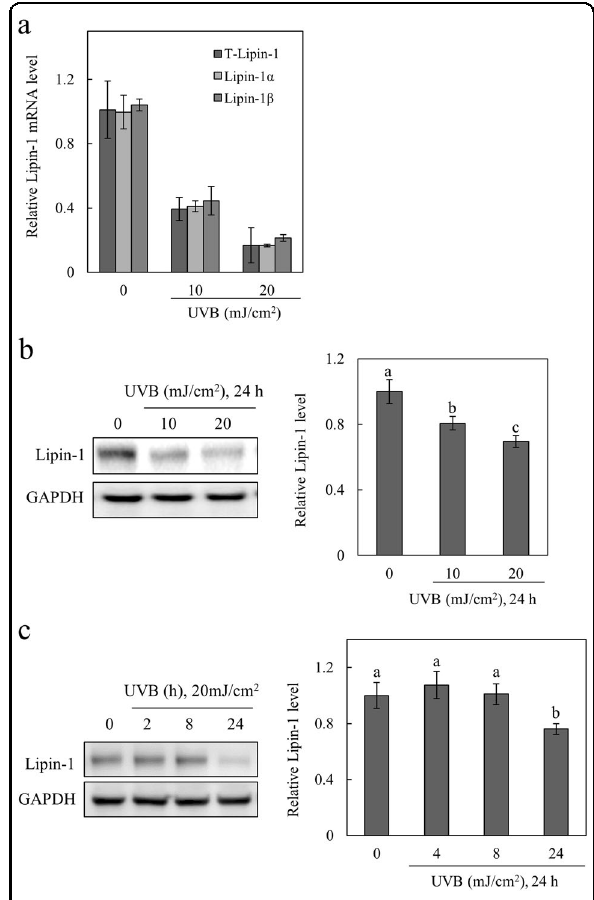
Fig. 1 UVB downregulates lipin-1 expression in NHEKs. NHEKs were treated with different doses of UVB (0, 10, and 20 mJ/cm 2 ) radiation and cultured for 24 h. a Total RNA was extracted from the cells, and relative mRNA levels of total (T) lipin-1, lipin-1 α , and lipin-1 β were measured via SYBR GREEN RT-PCR analysis. b Cell lysates were subjected to immunoblot analysis to assess lipin-1 expression levels. Protein levels of lipin-1 were normalized to GAPDH. c NHEKs were treated with 20 mJ/cm 2 UVB radiation and harvested at the indicated time points (0, 4, 8, and 24 h), and cell lysates were immunoblotted with anti-lipin-1 antibody. Protein levels of lipin-1 were normalized to GAPDH. All data (mean± SD) represent three independent experiments. Means without a common letter differ; P <